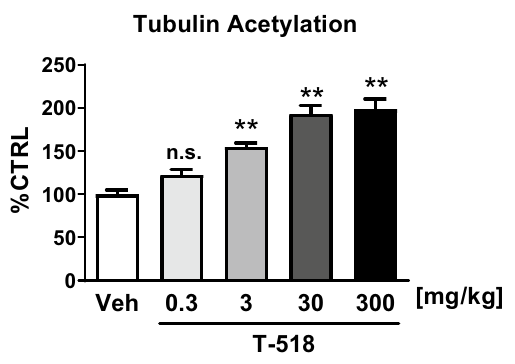
Figure 2. Selectivity profiling of HDAC6 inhibitors. Heat map summary of HDAC inhibition is shown ( A ). T-518 and hydroxamate HDAC inhibitors ACY-738, Ricolinostat, and Tubastatin A were treated to DIV6 mouse primary neural culture at 0.1–10 μM for assessment of tubulin acetylation ( B – E ) and at 3 and 30 μM for and H3 acetylation ( F , G ), respectively. Twenty-four hours after treatment, cell lysates were extracted with RIPA and tubulin acetylation was examined by ELISA and H3 acetylation was by Western blotting. Full-length blot of F is presented in Figure S5. Data are expressed as mean ± SD and analyzed statistically as follows: Williams test (* p < 0.05, ** p < 0.01 in B – E ), Dunnet test (** p < 0.01 in G ). n = 5. n.s. not significant.